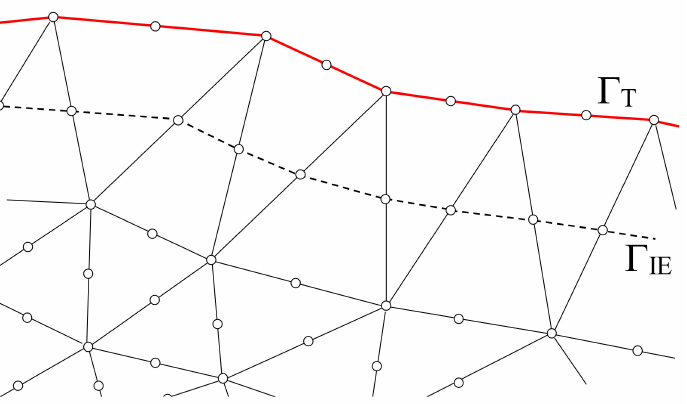
Figure 2. Truncation boundary Γ T and integration curve Γ IE (dashed line) in a mesh of triangular finite elements of the second